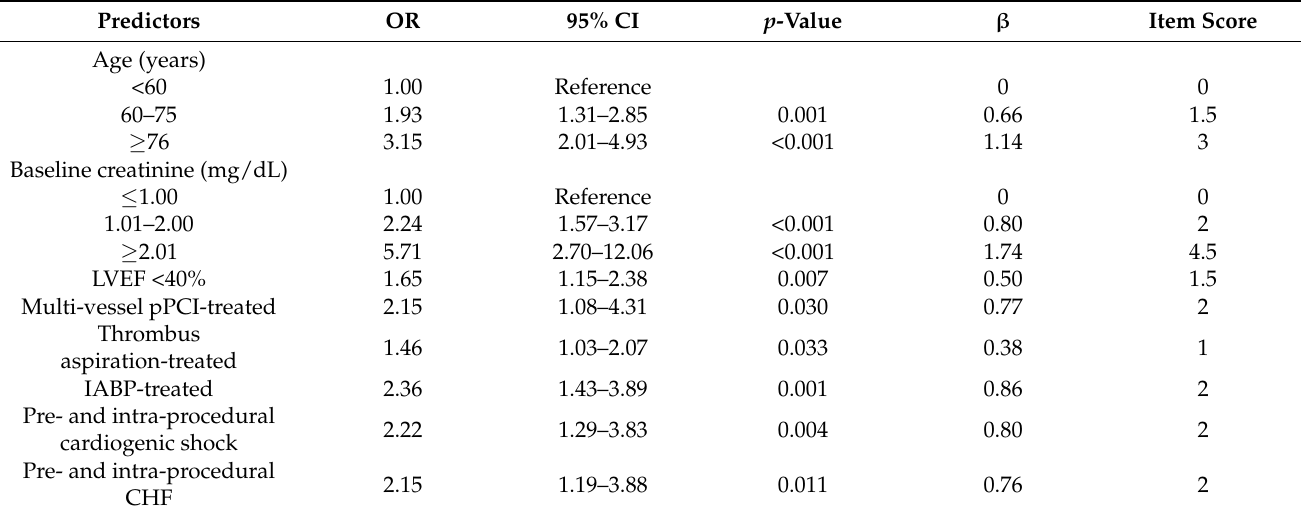
Table 2. Odds Ratio, 95% CI, coefficient ( β ), and assigned item score of significant predictors under multivariable regression analysis.